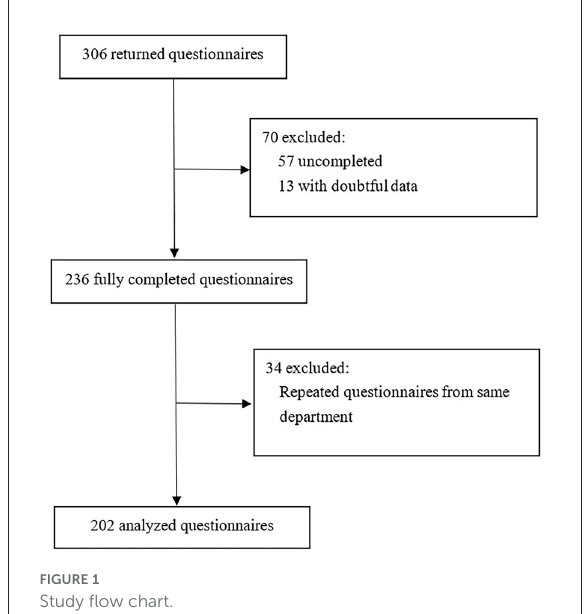
FIGURE1 Study flow